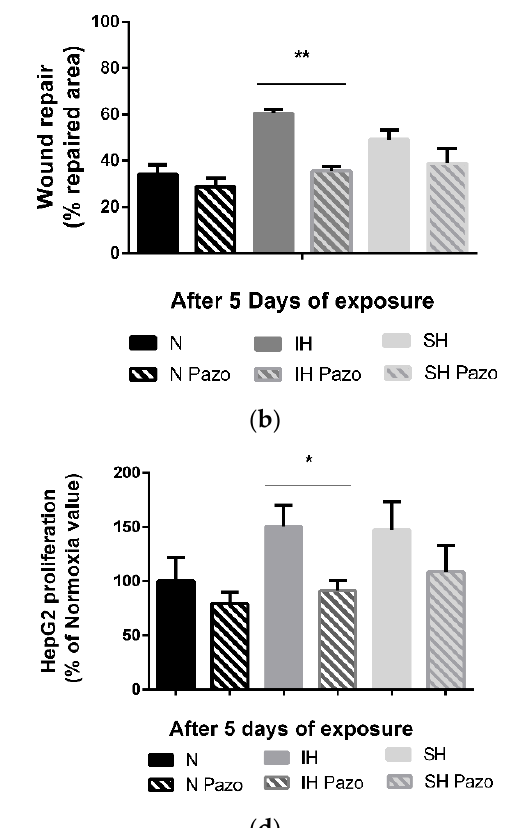
− 59% ( p < 0.01 vs. not treated cells), but pazopanib had no impact on proliferation in SH (Figure